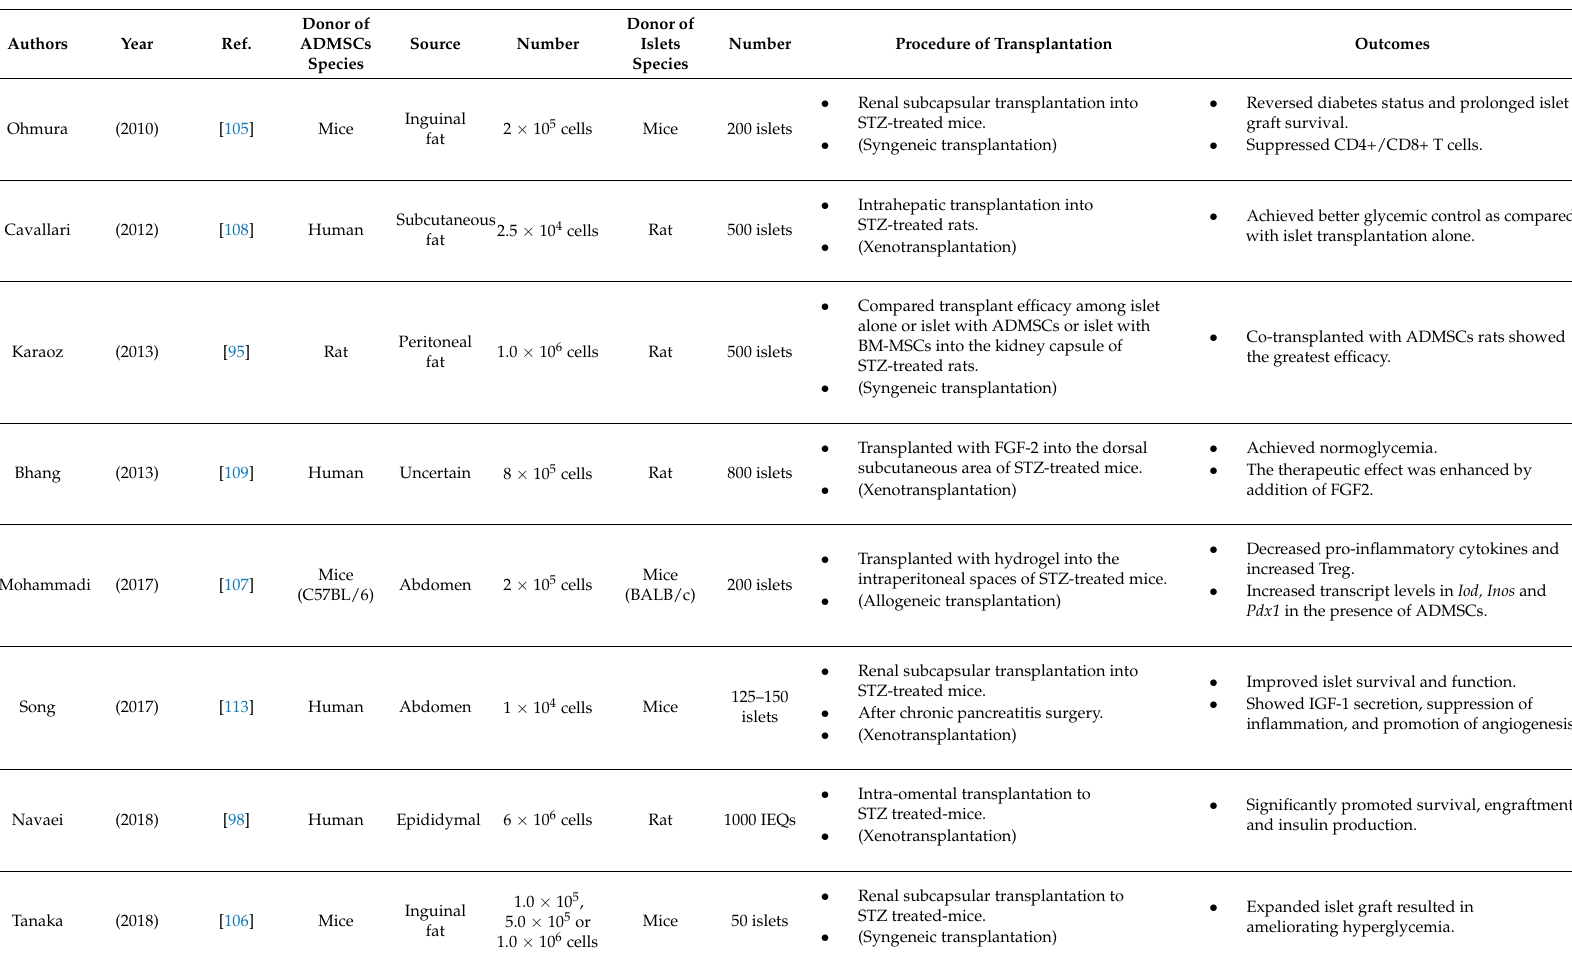
• (Syngeneic transplantation)